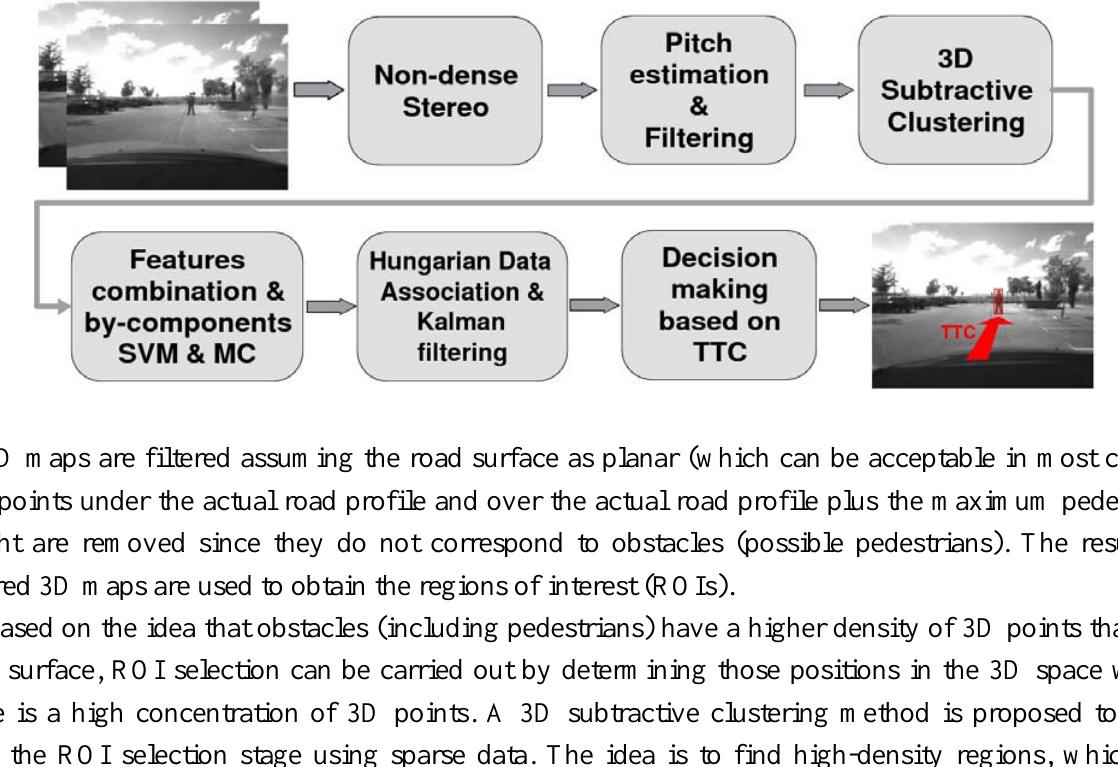
Figure 2. Overview of the stereo vision-based pedestrian detection